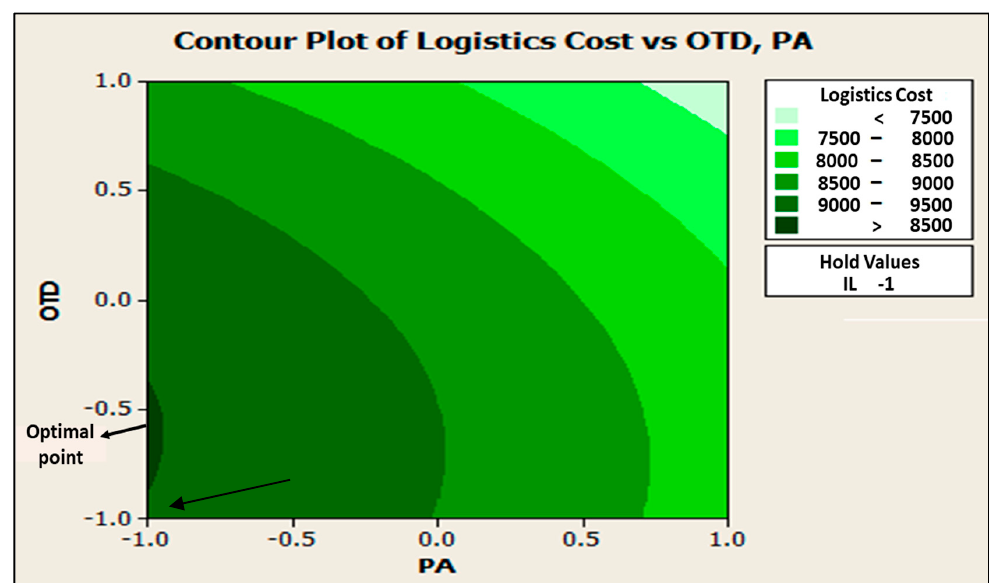
Figure 6. Surface Plot for Logistic Cost.